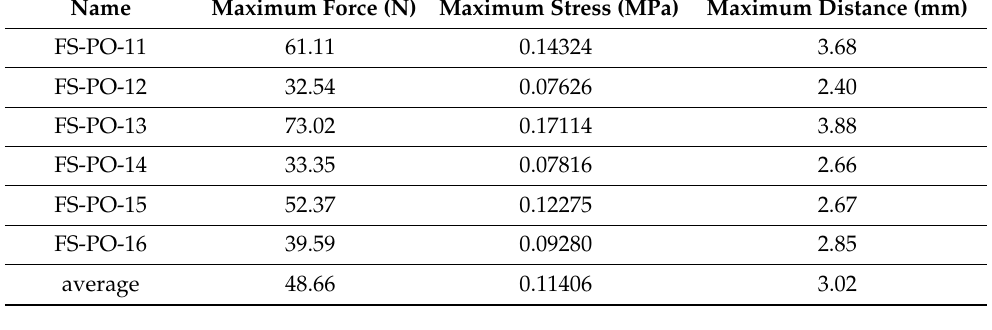
Table 4. Three-point flexural test of beech sawdust samples.